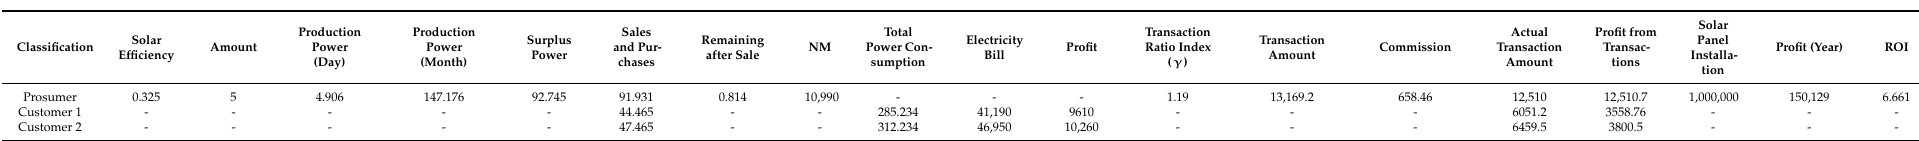
Table 4. The profits and ROI from the perspective of prosumers and customers based on simulated data of Prosumer 1 and Customers 1 and 2 (kWh,